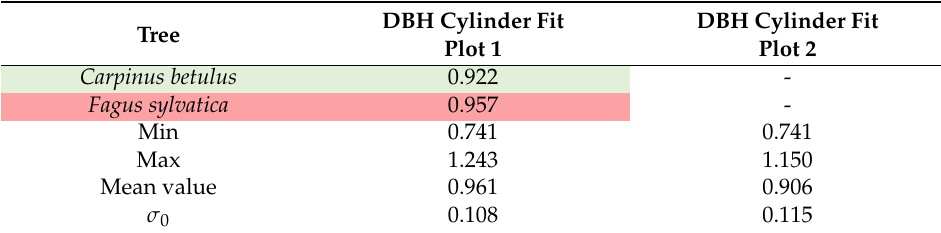
Table 3. Summary of the proportion DBH MLS /DBH TLS of the DBH derived from the QSM of 24 trees (plot 1) and 22 trees (plot 2) determined with TLS and MLS. The two trees from Figure 6 are marked with a green ( Carpinus betulus ) and red ( Fagus sylvatica ) color.